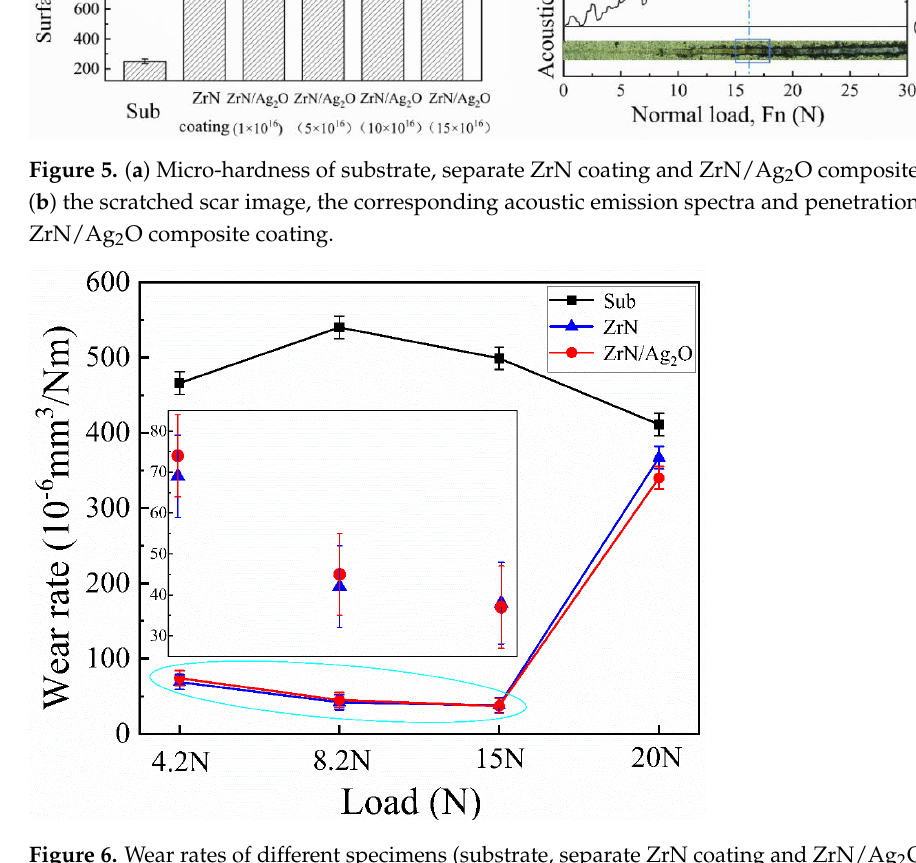
Figure 6. Wear rates of different specimens (substrate, separate ZrN coating and ZrN/Ag 2 O compo- site coating) under axial load from 4.2 to 20 N.